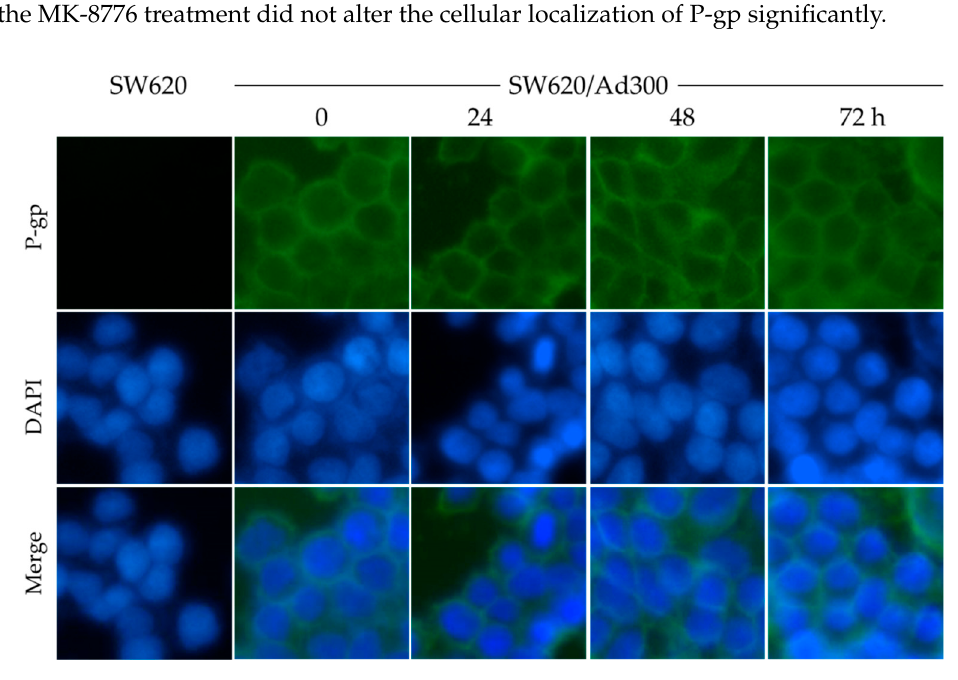
Figure 4. Effects of MK-8776 on the cellular localization of P-gp in P-gp-overexpressing SW620/Ad300 cells. Pictures were taken under 10× magnification microscope. Green: P-gp. Blue: nuclei.